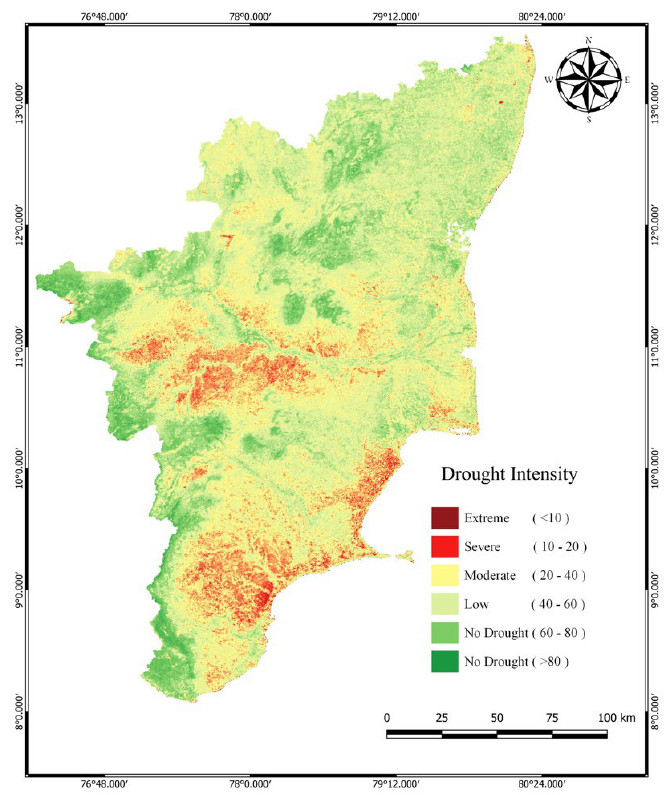
Figure 7. VCI map (drought intensity map) of Tamil Nadu for 2020.